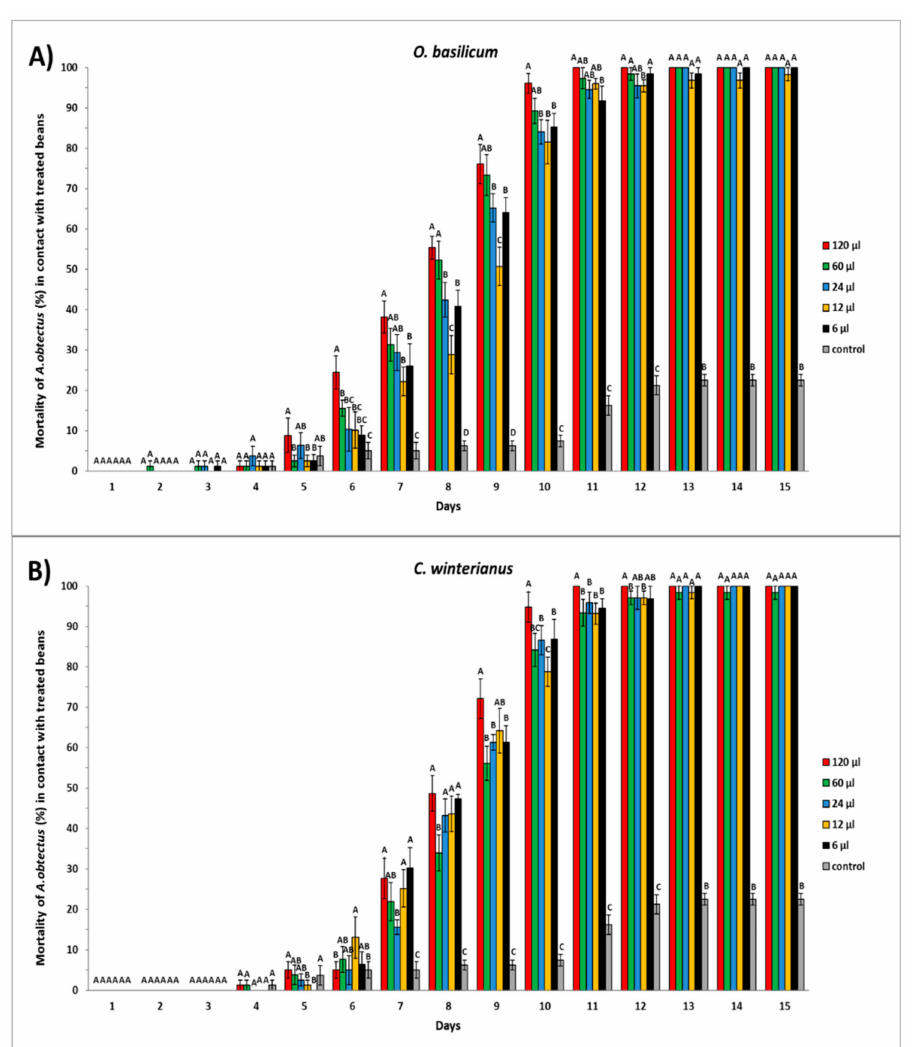
Figure 2. Mortality of A. obtectus in 0.33 L / glass jars exposed to beans treated with di ff erent doses of O. basilicum ( A ) and C. winterianus ( B ) essential oils. Di ff erent capital letters indicate significant di ff erences among doses and control for the same day; LSD test at 0.05. The symbols represent the mean of four replicates for each dose. Vertical bars represent the Standard Error (SE) of the